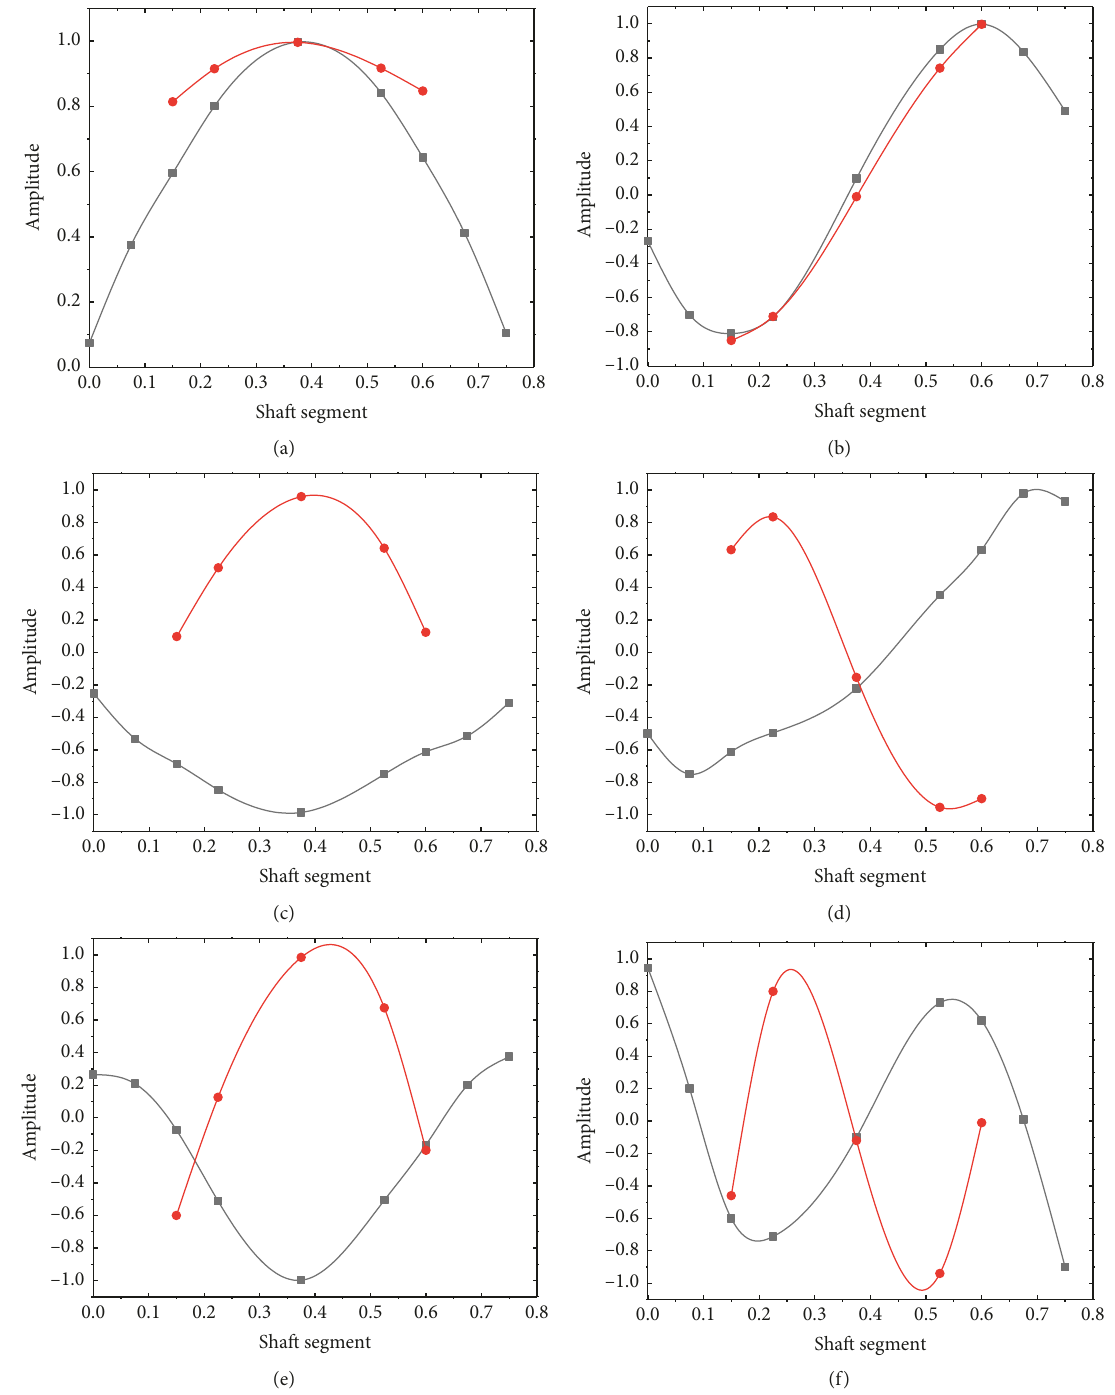
Figure 7: First six formation diagrams. (a) ω � 2119 . 37 rad/s. (f) ω (e) ω 5